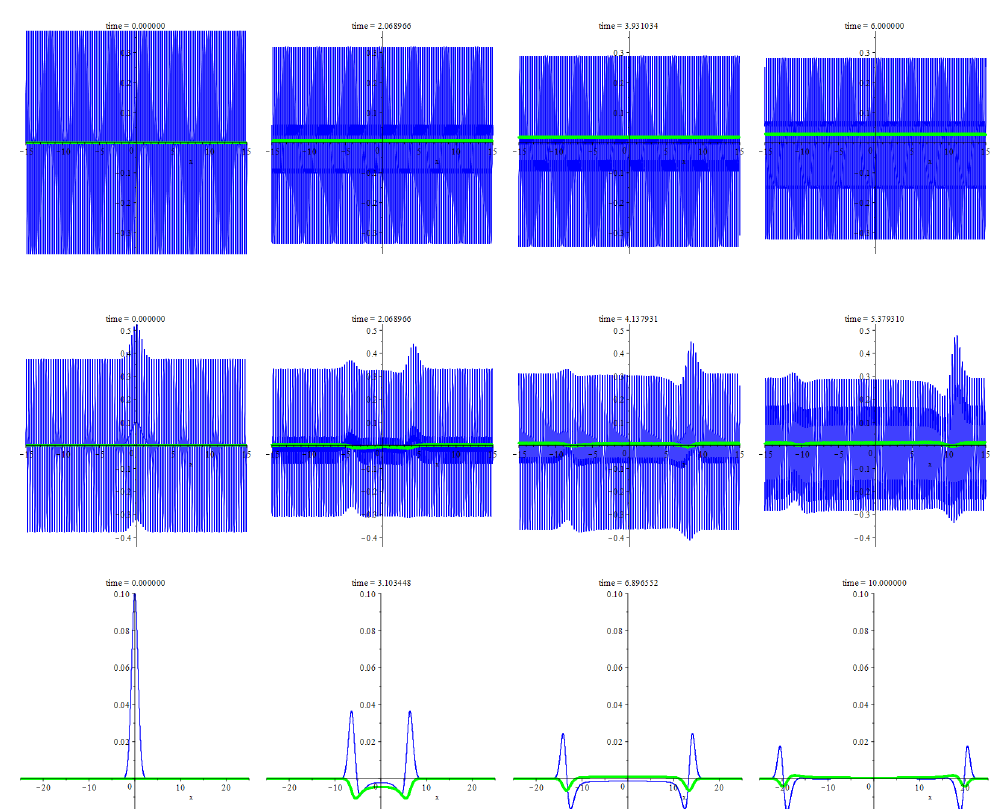
Figure 1. This figure shows the patterns produced by three versions of the initial data (5), see Table 1. Each frame shows instantaneous graphs of the deviation of the species densities from their equilibrium values. At that, blue (green) colour corresponds to the predator (prey) and the horizontal axis corresponds to the spatial coordinate, x . The upper (middle) row demonstrates the short-wave pattern produced by initial data (5) where (cid:101) = 0 ( (cid:101) (cid:54) = 0). The bottom row displays the decaying pattern produced by initial data (5) for a = 0. The snapshot timing, left to right, is t ≈ 0.0,2.0,3.9,6.0 for the upper row, t ≈ 0.0,2.0,41,5.38 for the middle row and t ≈ 0.0,3.1,6.9,10.0 for the bottom